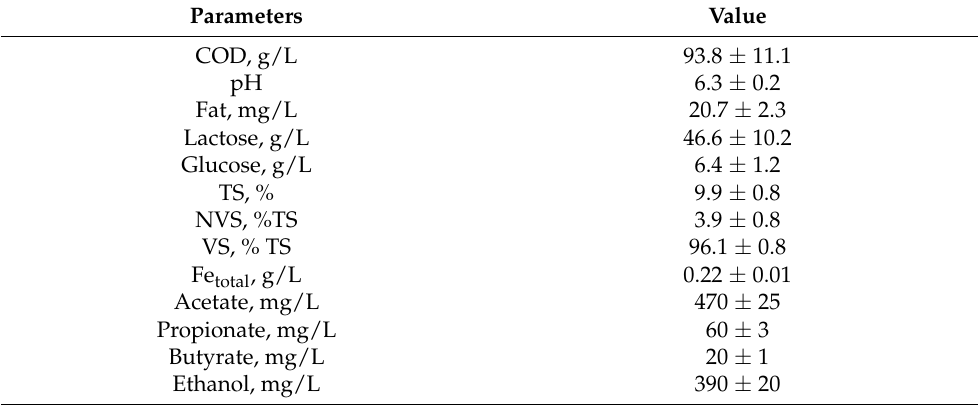
Table 1. Characteristics of